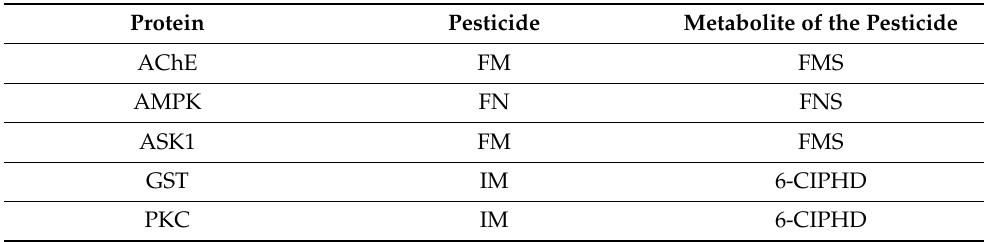
Table 1. Protein-pesticide and protein-pesticide metabolite complexes which were considered for the molecular dynamics (MD)